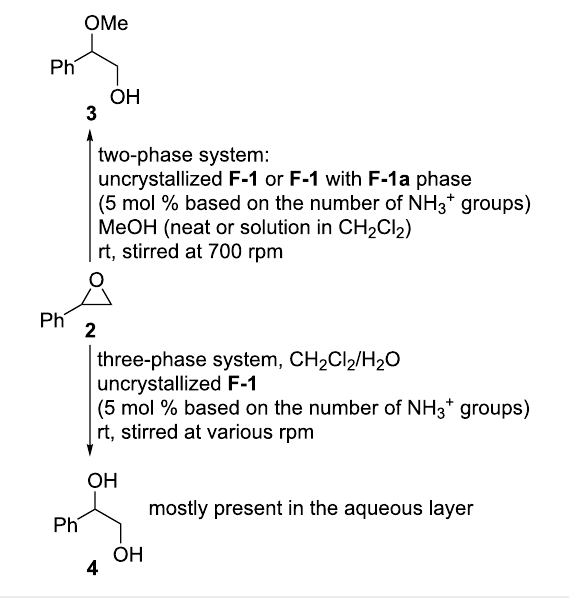
Scheme 2: Uncrystallized F-1 or F-1 with an F-1a phase promoted the two- and three-phase reactions of styrene oxide ( 2 ).